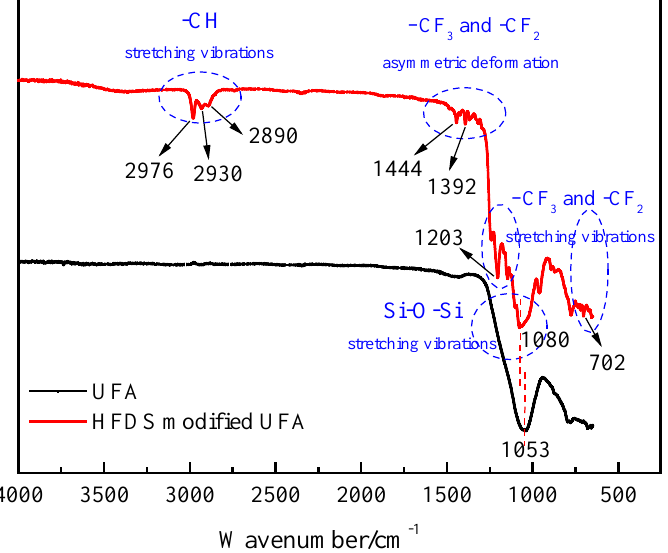
Figure7. Figure 7. Structural configuration of UFA and HFDS modified UFA (1 mL HFDS, 5 g UFA, and 50 mL ethanol).